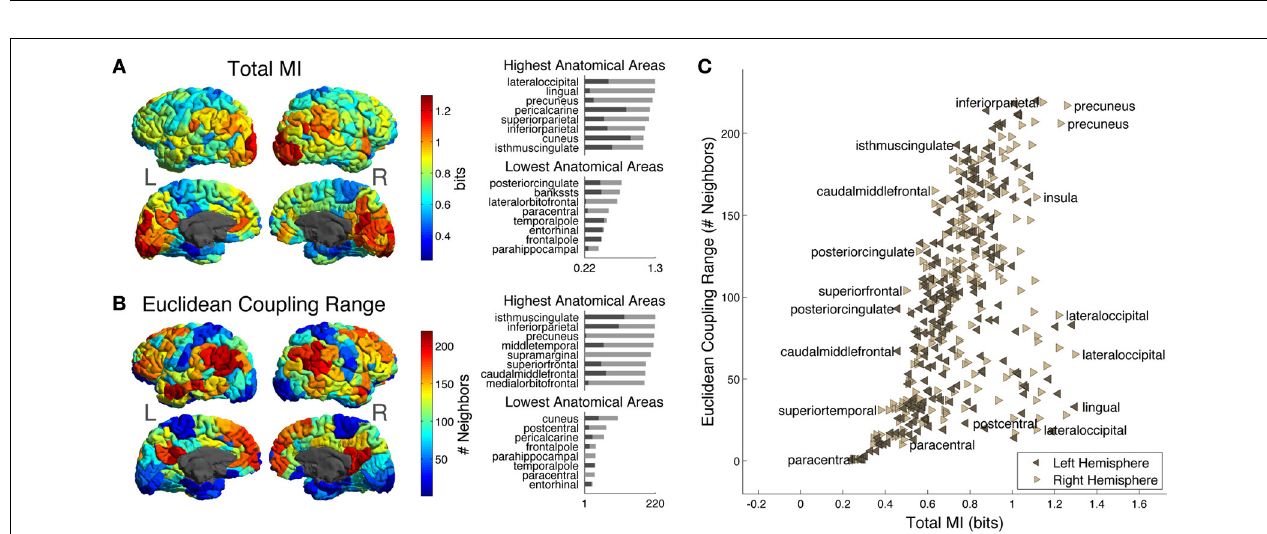
built according to the three distance metrics. The illustration in the top left corner diagrams how this measure is computed for a given seed and subsystem of size 3. (C) Seed-Environment MI between seeds and environments built according to the three distance metrics. The illustration in the top right corner diagrams how this measure is computed for a given seed and subsystem size 3 (environment size 4). The horizontal dotted line indicates 0.3 bits of Seed-Environment MI, a threshold used later in our definition of Euclidean Coupling Range.